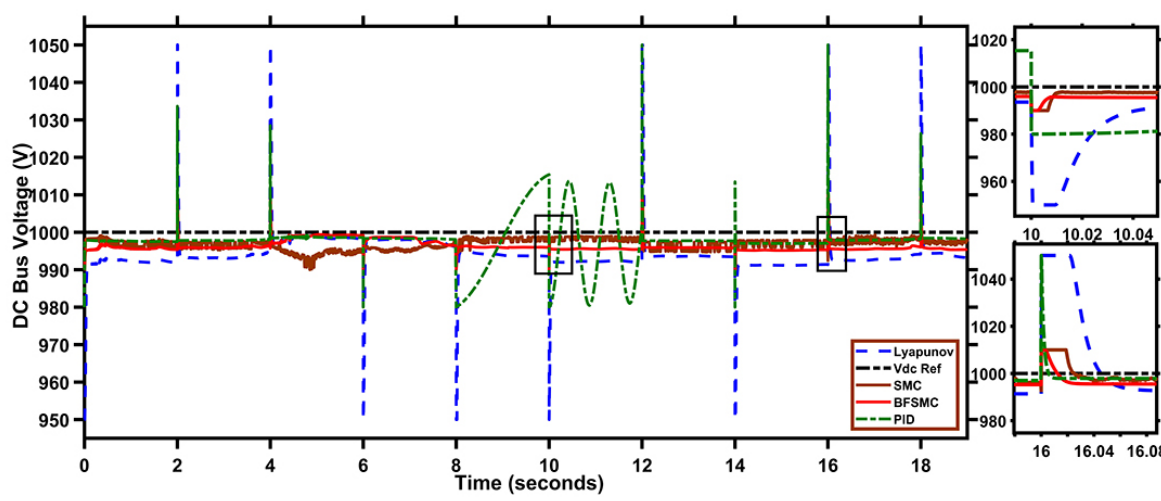
Figure 10. DC bus voltage comparison during islanded